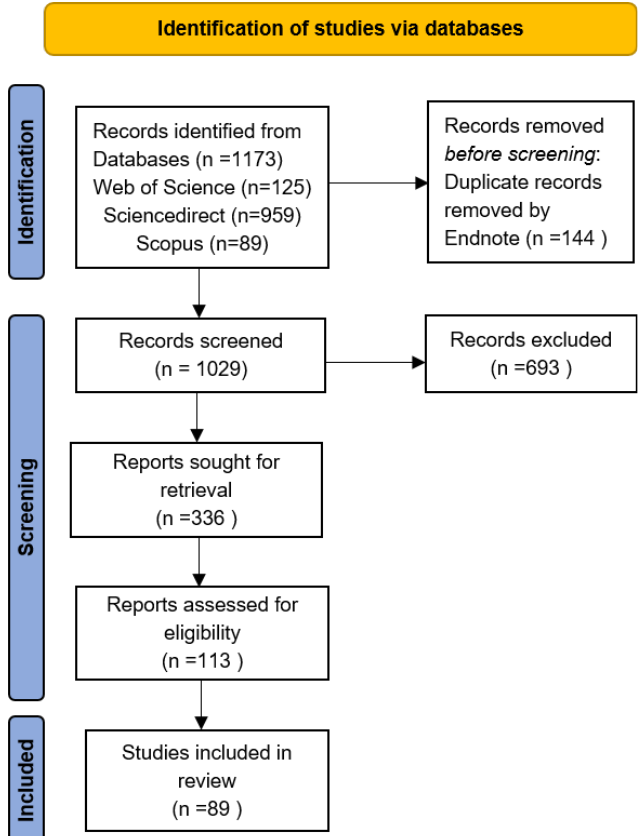
Figure 1. PRISMA flowchart showing data collection, exclusion, and inclusion criteria